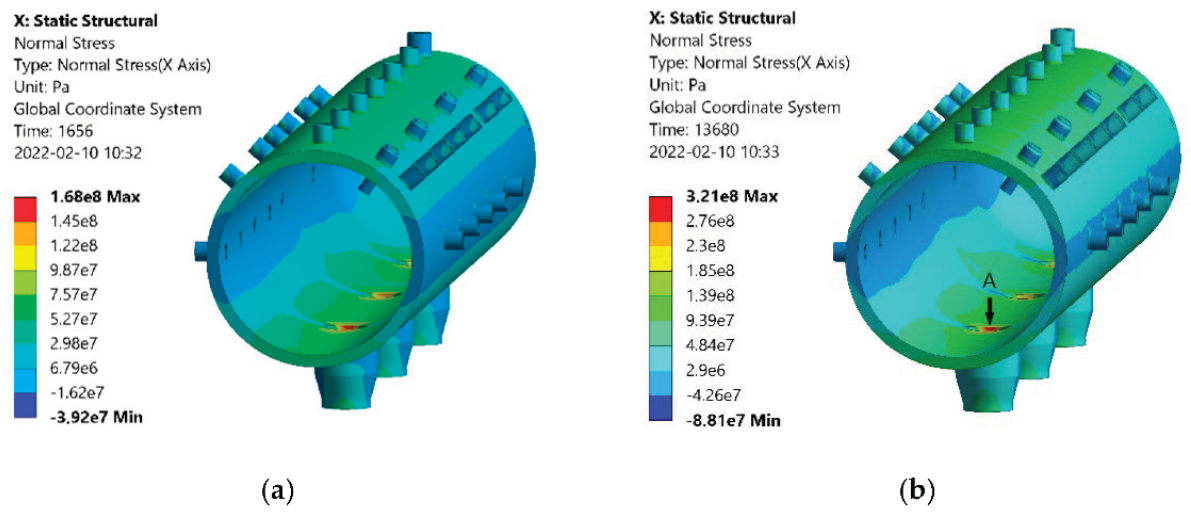
Figure 9. Examples of σ x component stress distributions on the internal and external surfaces of the drum, and on the planar cross-section, at ( a ) 1656 s into the OR HOT startup OR HOT, and ( b ) 13,680 s into OR HOT startup. The time-dependent stress and strain changes were determined at point A, as indicated on Figure 9b. This point is located on the edge of the downpipe in the area with the highest stress. Stress versus strain characteristics were also determined at this point. Figures 10–13 present circumferential stress and strain results for points along the edges of the downpipe spouts, where the hoop stresses reached the highest values. Such hoop stresses are important criteria for the assessment of pressure vessel fatigue life